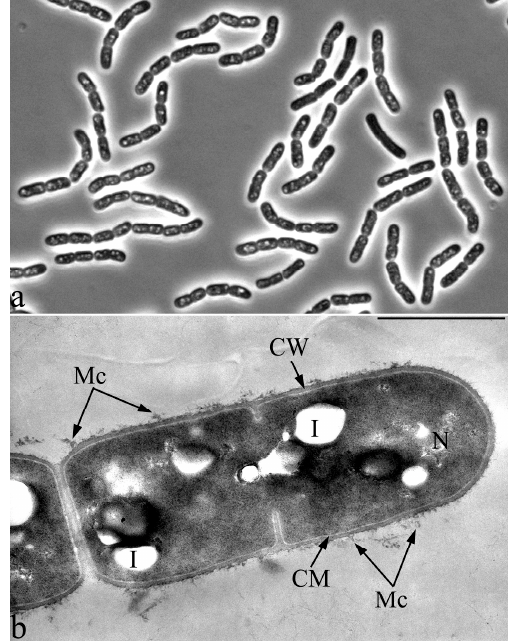
Figure 8. Priestia aryabhattai strain 25 in the phase of exponential growth (1 day) in the form of chains of rod-shaped cells with multiple intracytoplasmic inclusions. Designations: CM—cytoplasmic membrane, CW—cell wall, I—inclusion, N—nucleoid and Mc—microcapsule. ( a ) Light microscopy. Phase contrast. Bar—10 µm. ( b ) Transmission Electron Microscopy. Ultrathin section. Bar—1 µm.